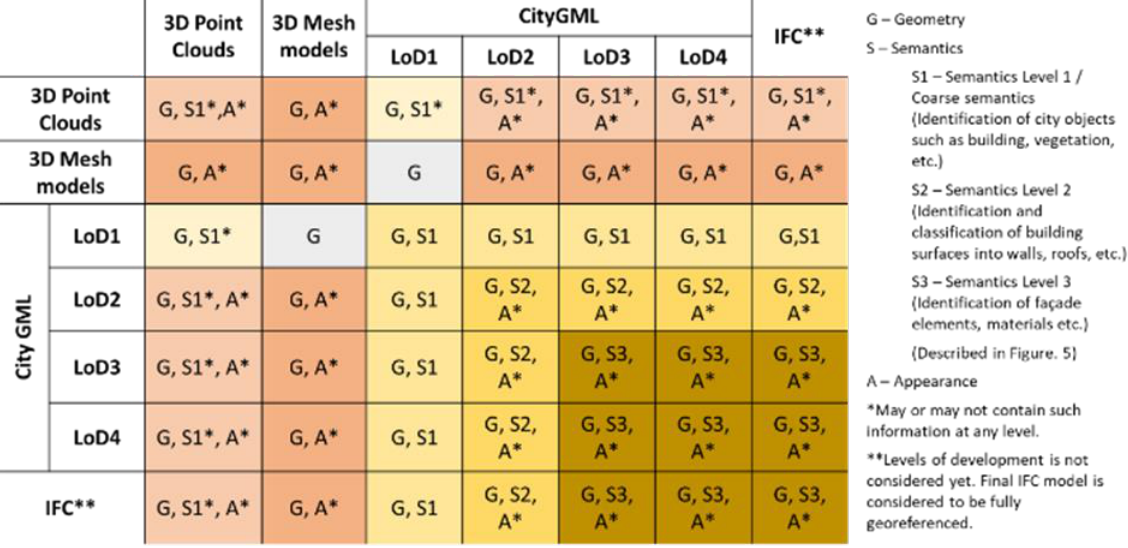
Figure 4 Modelling aspects that have to be taken into account when comparing different 3D model